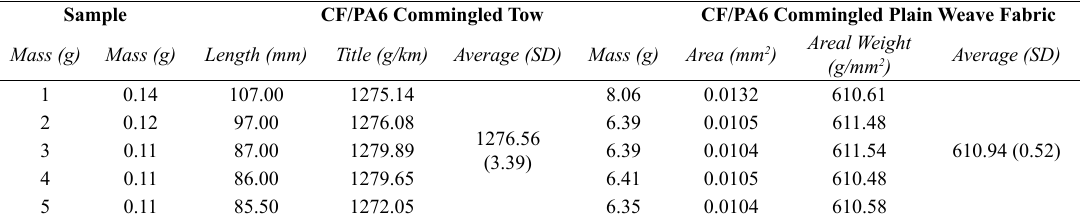
Table 4. CF/PA preform